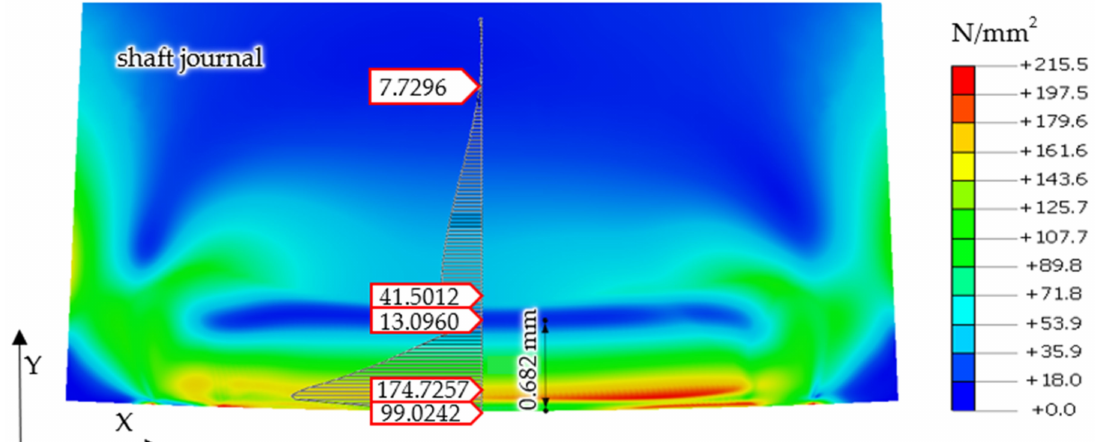
Figure 17. Distribution of permanent stress values in the surface layer of the steel shaft journal, with the actual profile of journal No. 10, after this profile has been turned over the steel support roller.